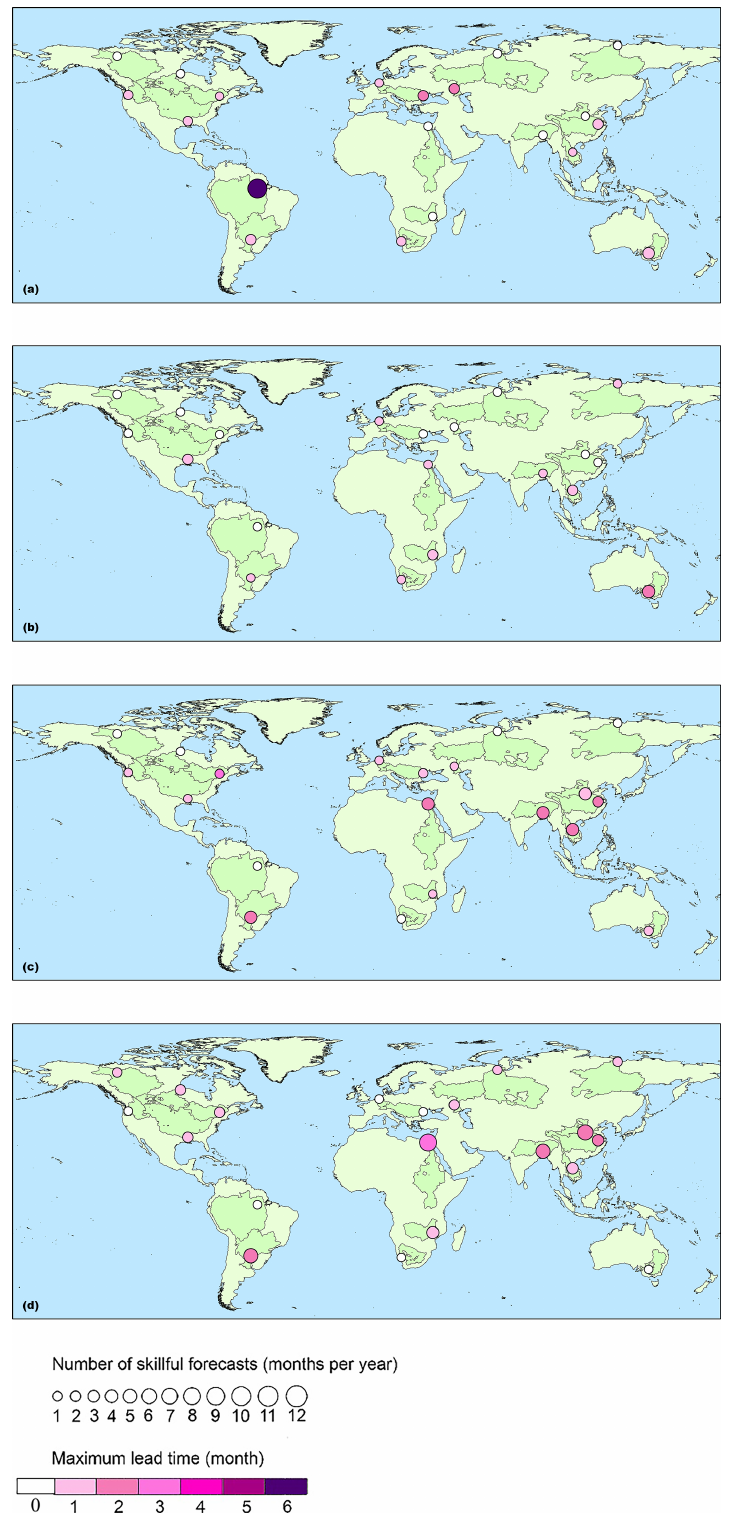
Figure 2. Global overview of basins with improved forecast skill. Panels (a) theoretical skill in low flows, (b) theoretical skill in high flows, (c) actual skill in low flows, (d) actual skill in high